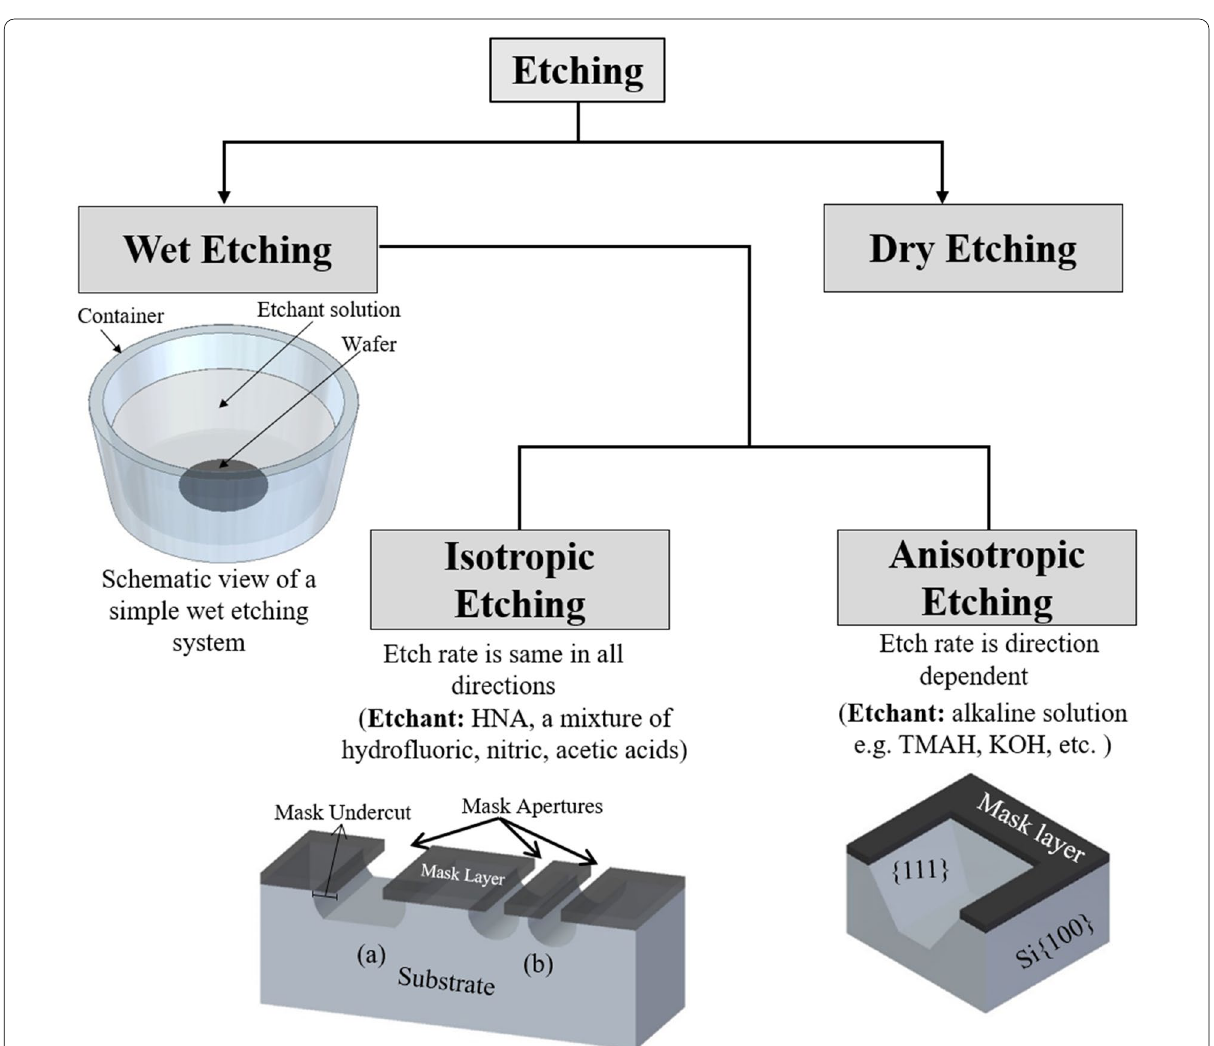
Fig. 1 Classification of silicon etching used for the fabrication of micro/nanomechanical structures using silicon